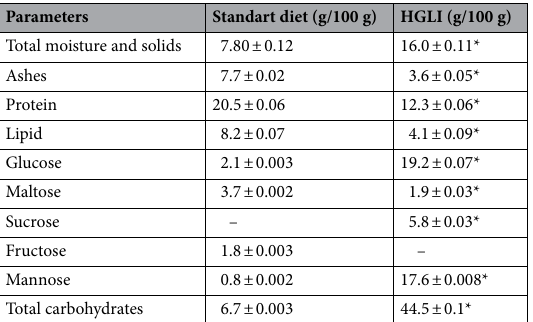
Table 1. Centesimal composition of the standard diet (Nuvilab) and HGLI. Data are expressed as the mean ± s.e.m. (n = 3). Test t. * p < 0.05 (standard diet vs. HGLI).